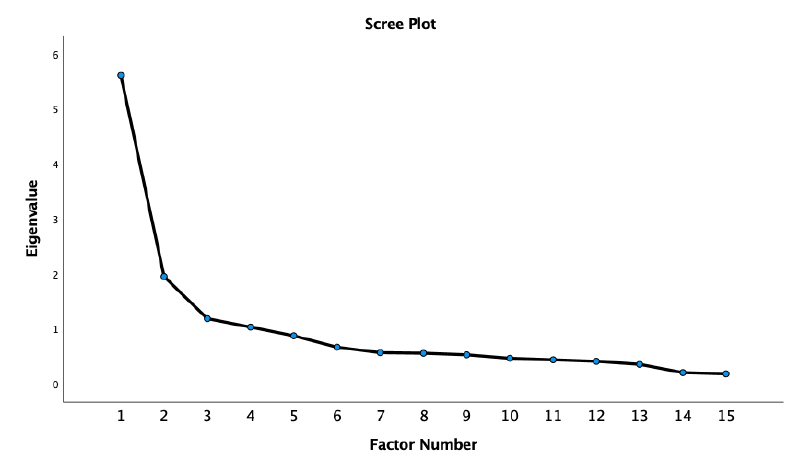
Figure 2. EFA Scree plot.